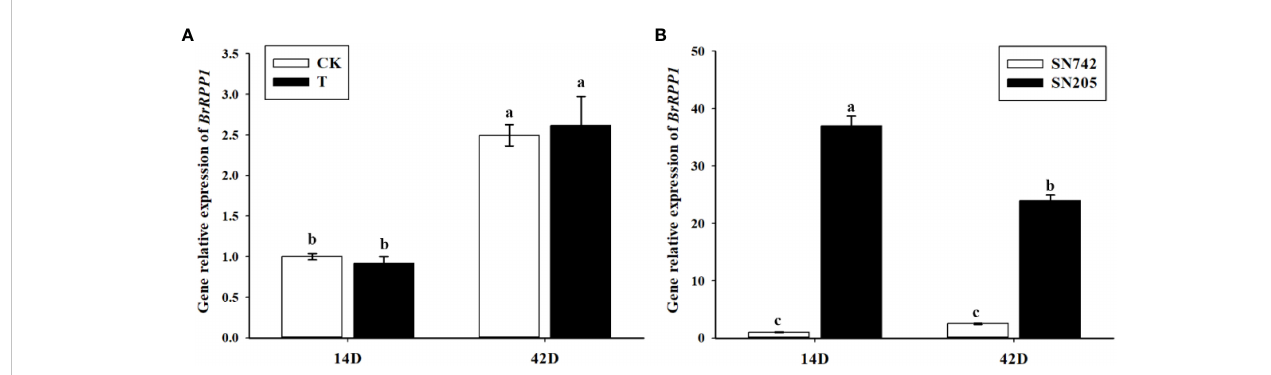
FIGURE 3 The analysis of relative expression of BrRPP1 gene. (A) The expression difference of BrRPP1 between uninoculated and inoculated roots with P. brassicae. 14D, the 14th day after inoculation of P. brassicae . 42D, the 42th day after inoculation of P. brassicae . CK, uninoculated control roots. T, roots treated with P. brassicae . (B) The expression of BrRPP1 in roots of ‘ SN742 ’ and ‘ SN205 ’ uninoculated with P. brassicae . Data represent the mean ± standard deviation (n = 3); letters indicate signi fi cant differences at p ≤ 0.05, according to Duncan ’ s multiple range